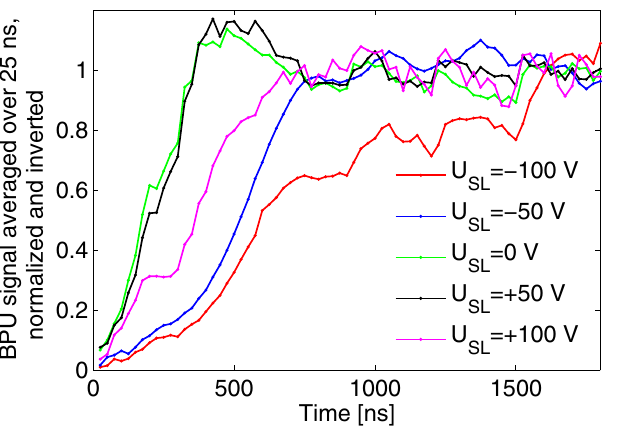
FIG. 11. (Color) Electron cloud buildup time (50% rise time) compared to the maximum electron signal at the end of the bunch train. As the bunch length decreases during the last tens of milliseconds before ejection, the EC signal increases while its buildup is accelerated. The bunch compression and rotation have a very distinct effect on both EC parameters.